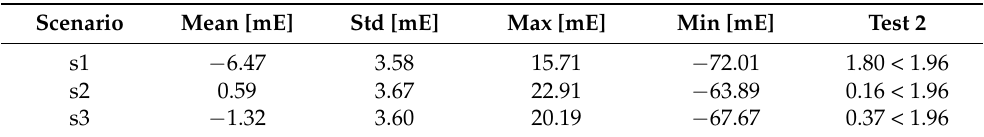
Table 3. Statistics on the differences of the forwarded gravitational signal from the solutions